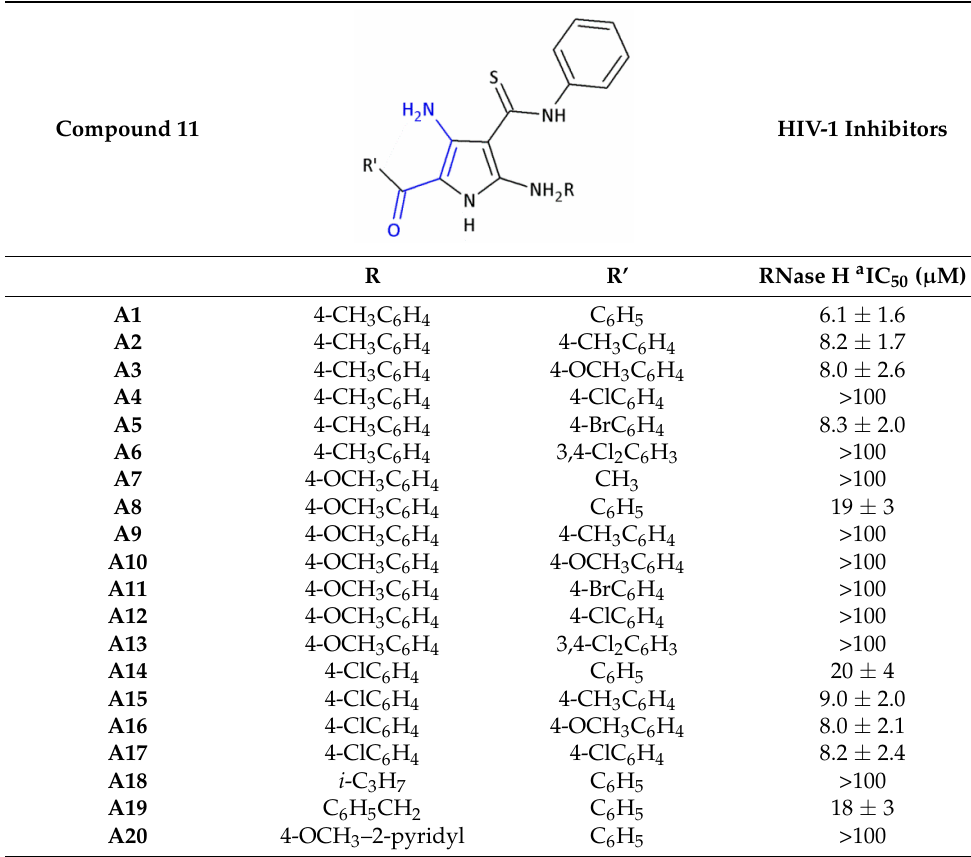
Table 2. 4-chlorobenzoylpyrrole derivatives acting as HIV-1 inhibitors